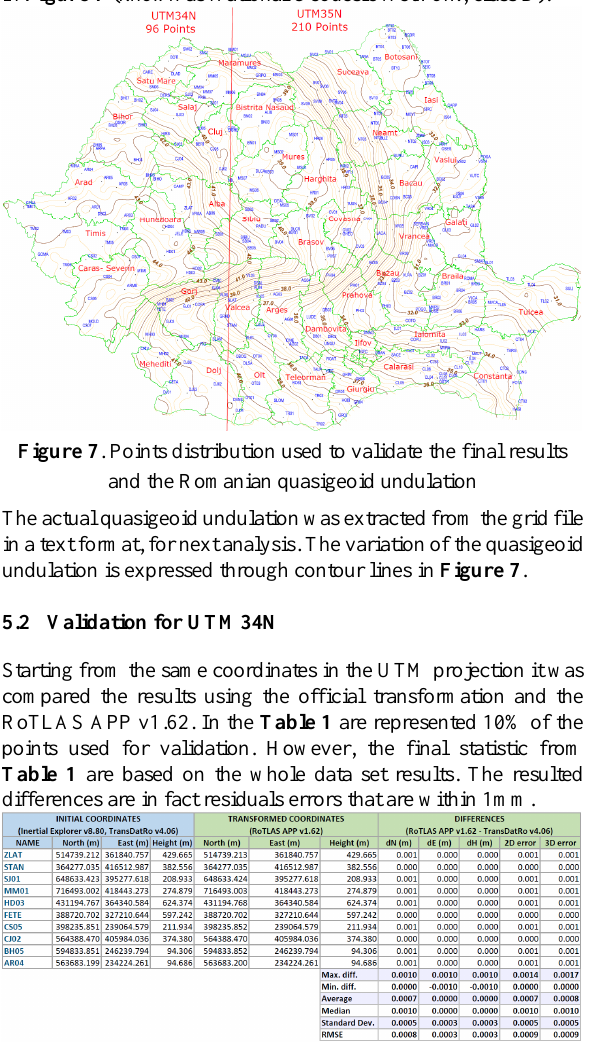
Table 1 . Validation statistics for transformation from UTM 34N